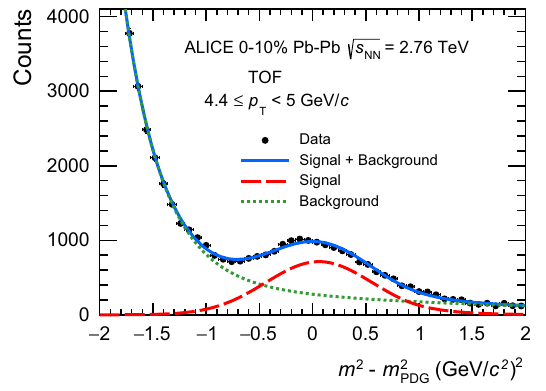
Fig. 1 The m 2 − m 2 distributions obtained using the TOF detector PDG (left) and with the HMPID detector (right) in two different p T inter- vals (4 . 4 ≤ p T < 5 GeV / c and 5 ≤ p T < 6 GeV / c ) for positive tracks in the 0–10% centrality class. Here m PDG is the nominal mass